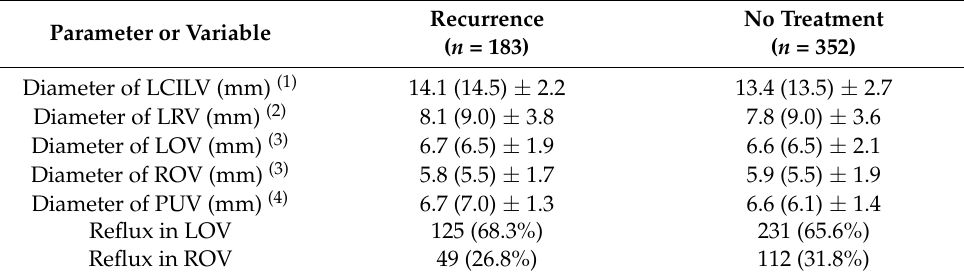
Table 4. The selected morphological and hemodynamic parameters of abdominal and pelvic veins found in second-step assessment with either CT-V or MR-V. The values shown in the table represent the mean (median) ± SD, or the number (percentage) of patients in the group, respectively.